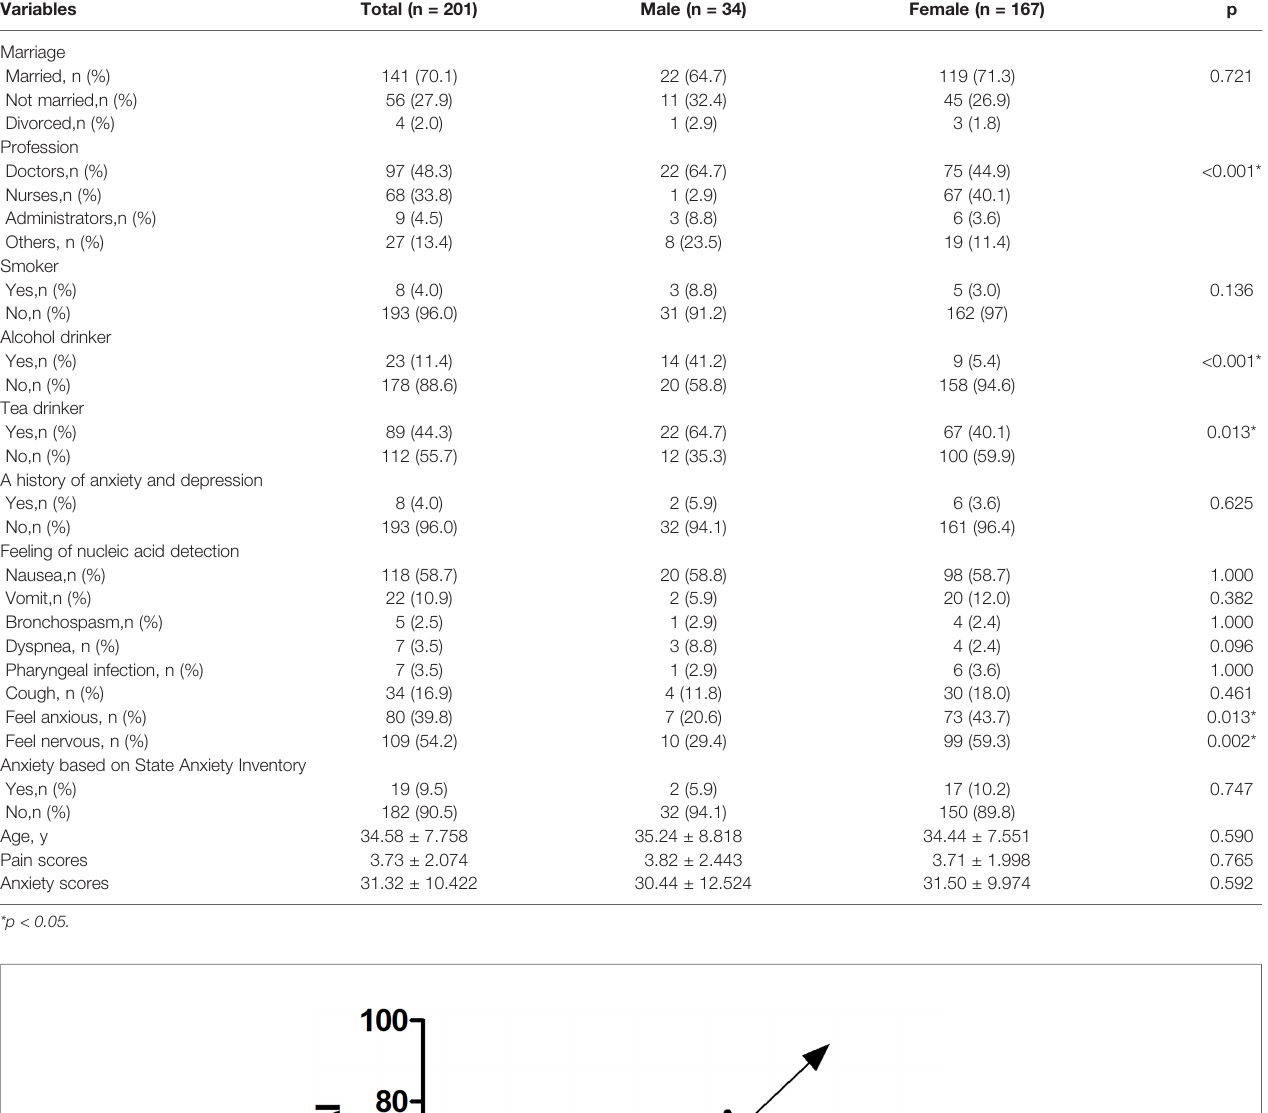
TABLE 1 | General demographic information of the